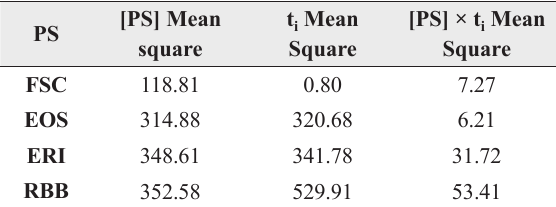
Analysis of the obtained ANOVA mean